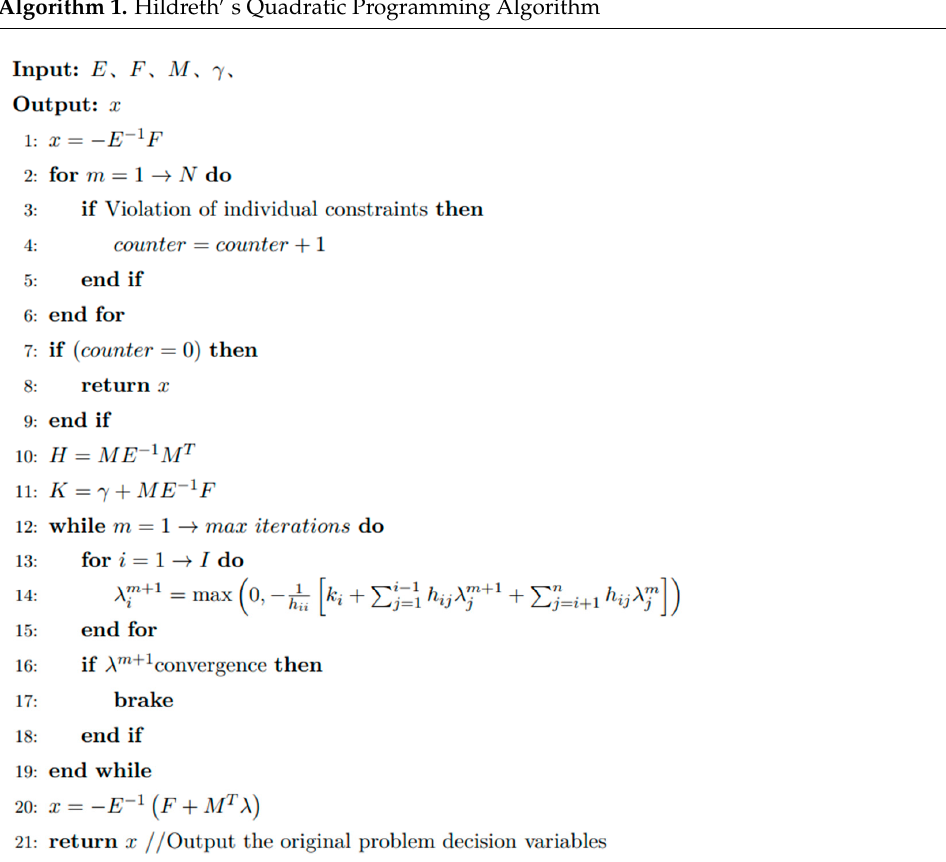
Algorithm 1. Hildreth (cid:48) s Quadratic Programming